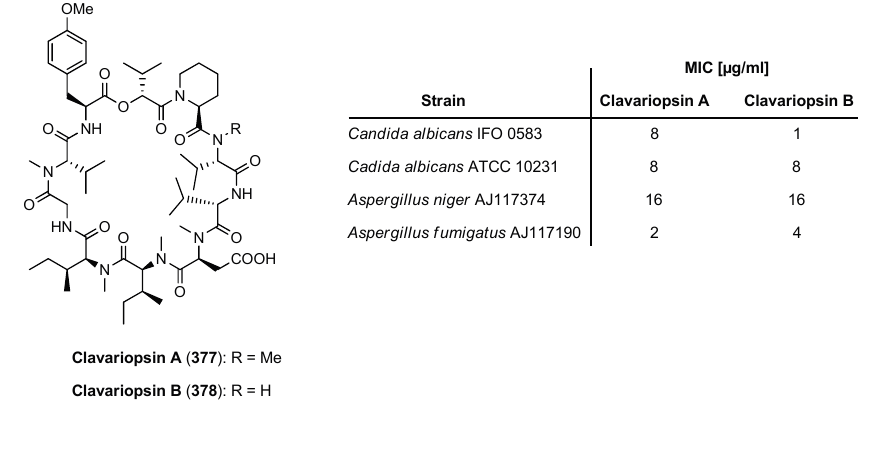
Figure 34. Structures of clavariopsins A and B and their antifungal